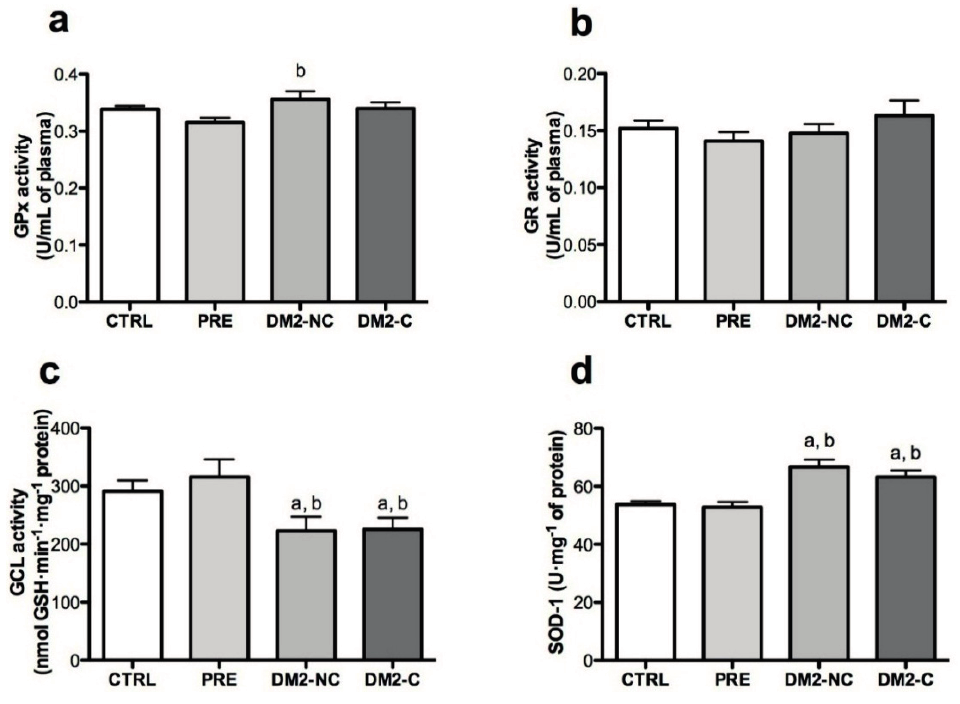
Figure 2. Activity of antioxidant enzymes. Plasma activity of ( a ) Glutathione peroxidase (GPx) and ( b ) Glutathione reductase (GR) and ( c ) γ -Glutamate cysteine ligase (GCL) and ( d ) Cu-Zn-superoxide dismutase (SOD) activities in erythrocytes hemolysates. CTRL: control, PRE: prediabetes, DM2-NC: diabetic subjects without glycemic control (glycated hemoglobin ≥ 7%), DM2-C: diabetic subjects under glycemic control (glycated